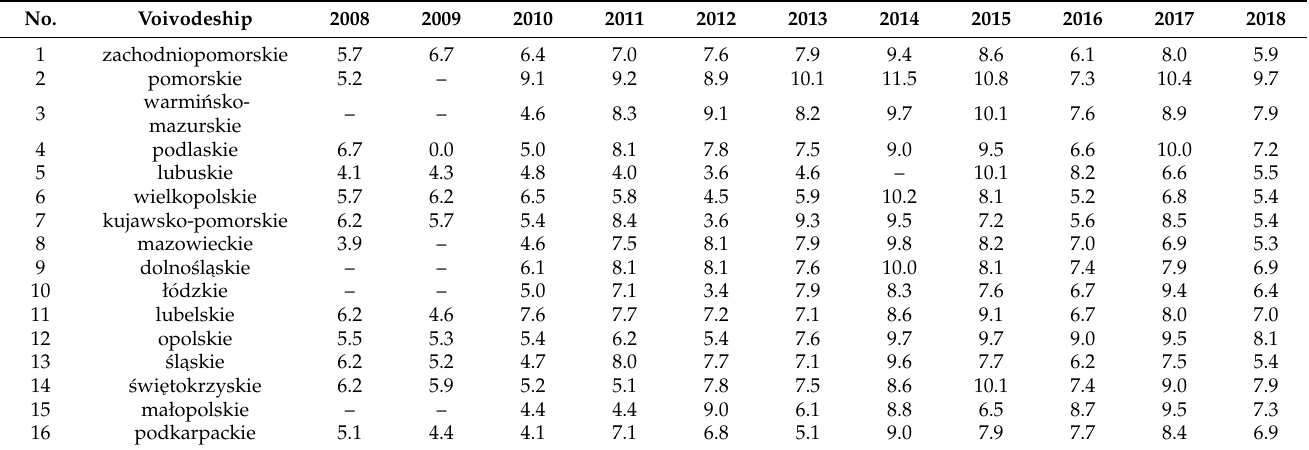
Table 2. Grain yield of winter wheat [t/ha] in each voivodeship in each studied year for both commercial and experimental farms together. Numbers of voivodeships are the same as in Figure